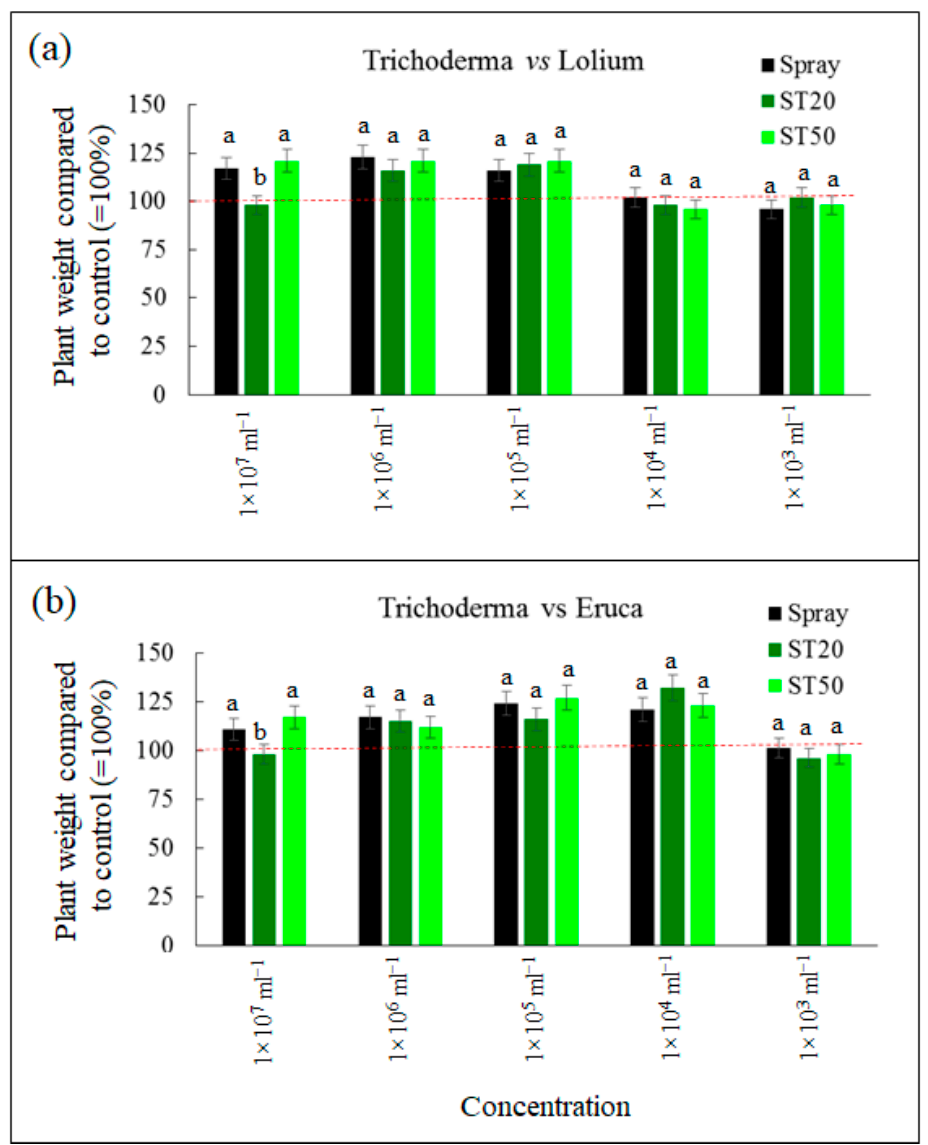
Figure 10. Growth of Lolium perenne ( a ) and Eruca vesicaria ( b ) treated with Trichoderma harzianum at five concentrations with spray system, ST20, and ST50. Data are means ± standard deviation; different letters indicate statistically significant differences within concentration (Duncan’s test). The red line indicates the growth of the untreated control.